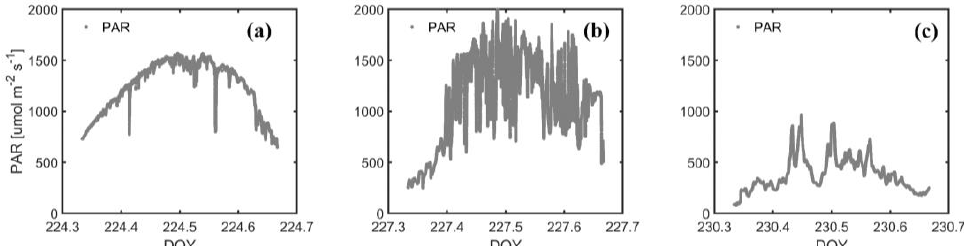
Figure 4. The diurnal dynamics of PAR under three sky condition days: ( a ) the clear day (DOY 224), ( b ) the rapidly fluctuating illumination condition day (DOY 227), and ( c ) the cloudy day (DOY 230). The gray dots represent the high−frequency PAR data.